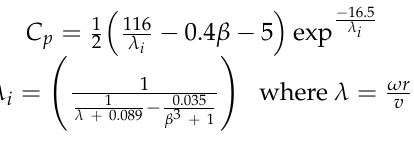
Table 4. Design parameters of the wind turbine. Parameter Value Ref.